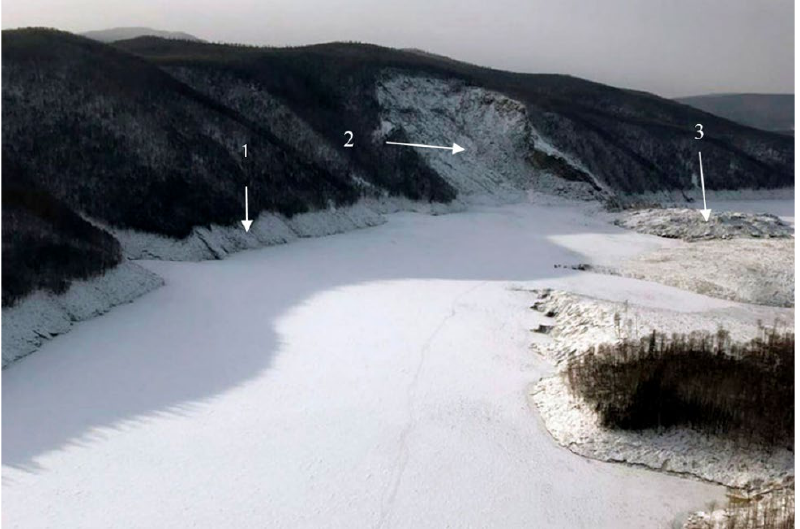
Figure 4. Picture of the landslide circus, view from the northeast (arrow 1—forest-free belt; arrow 2—sliding surface; arrow 3—slump debris).